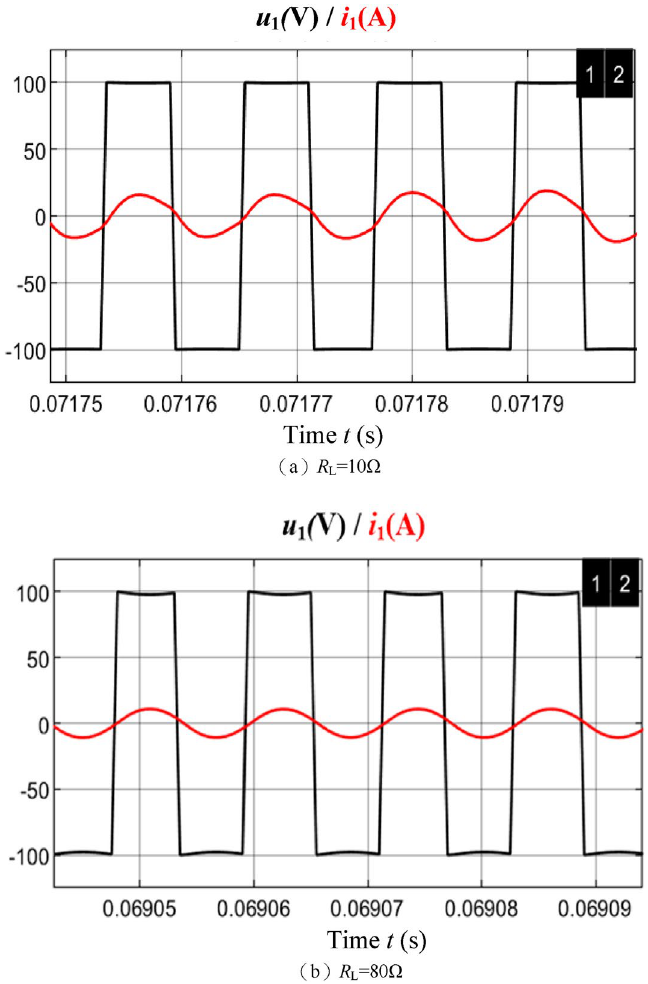
Figure 9. Inverter output voltage and current